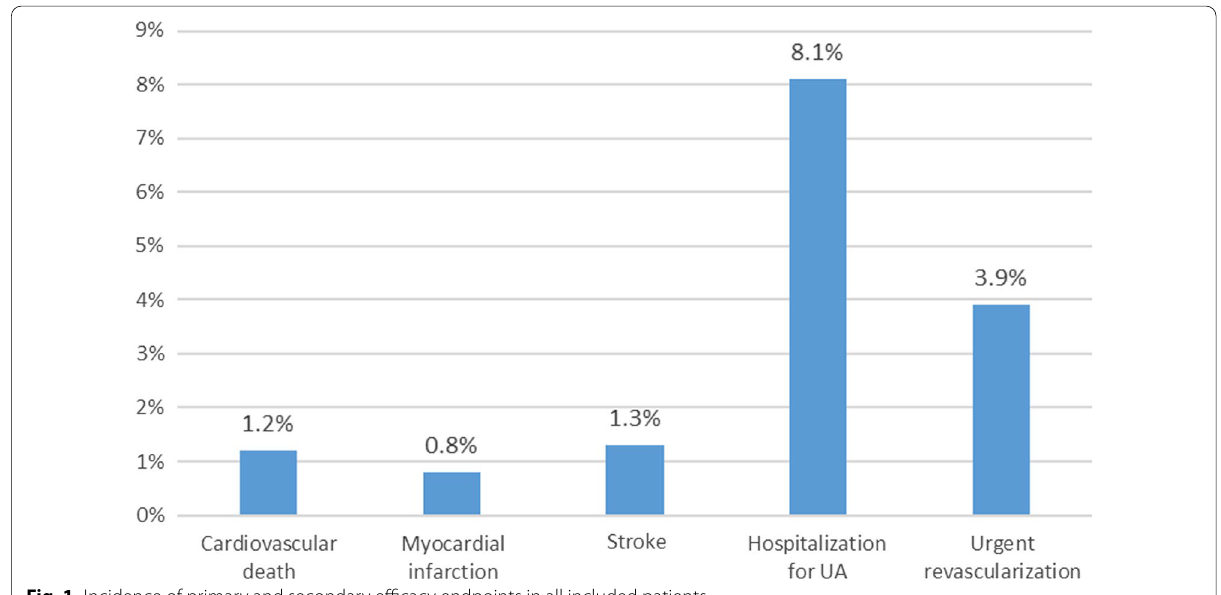
Fig. 1 Incidence of primary and secondary efficacy endpoints in all included patients